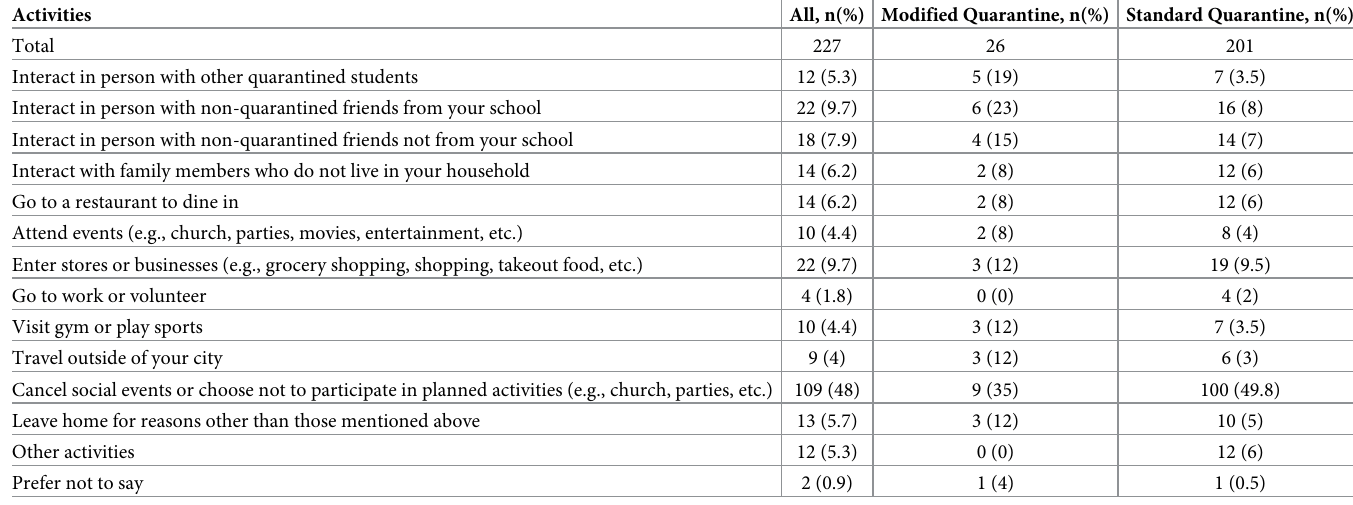
experiences. Examples of quotes, arranged by quarantine type and stress level, can be found in Fig 1. Parents of students in SQ in St. Louis County more frequently reported negative mental health impacts (n = 46, 28%) than parents of students in MQ (n = 4, 15%) and parents of Table 4. Non-school related activities reported by parents/guardian of K-12 student close contacts.